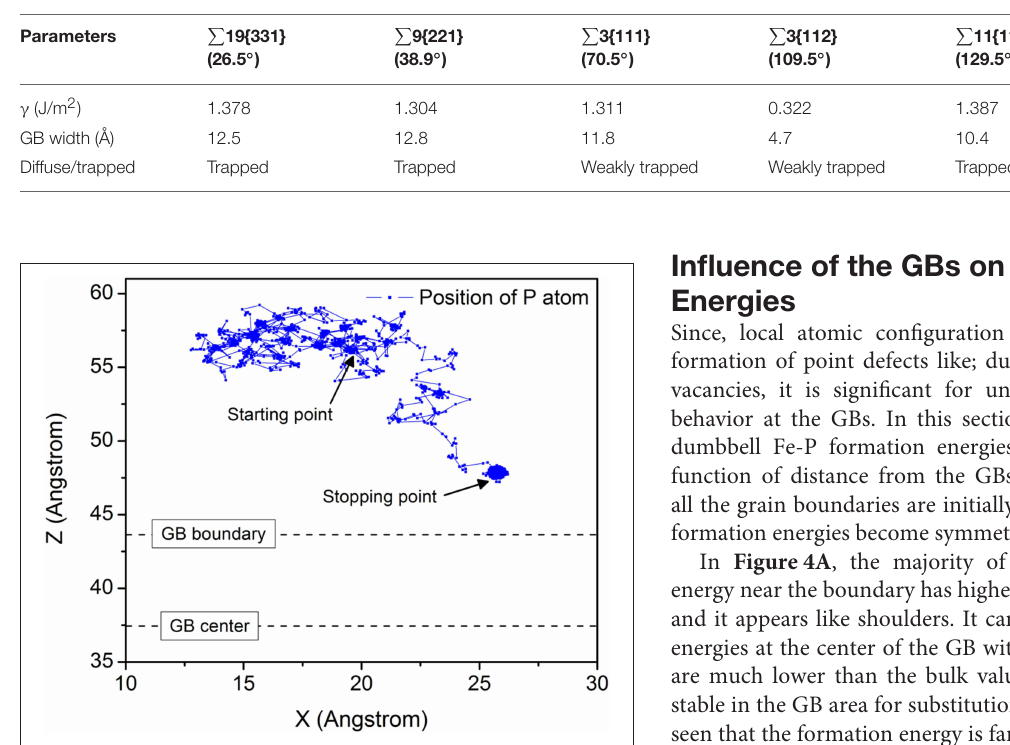
FIGURE 2 | P atom trajectory in X-Z plane of model P 19{331} at 600K.